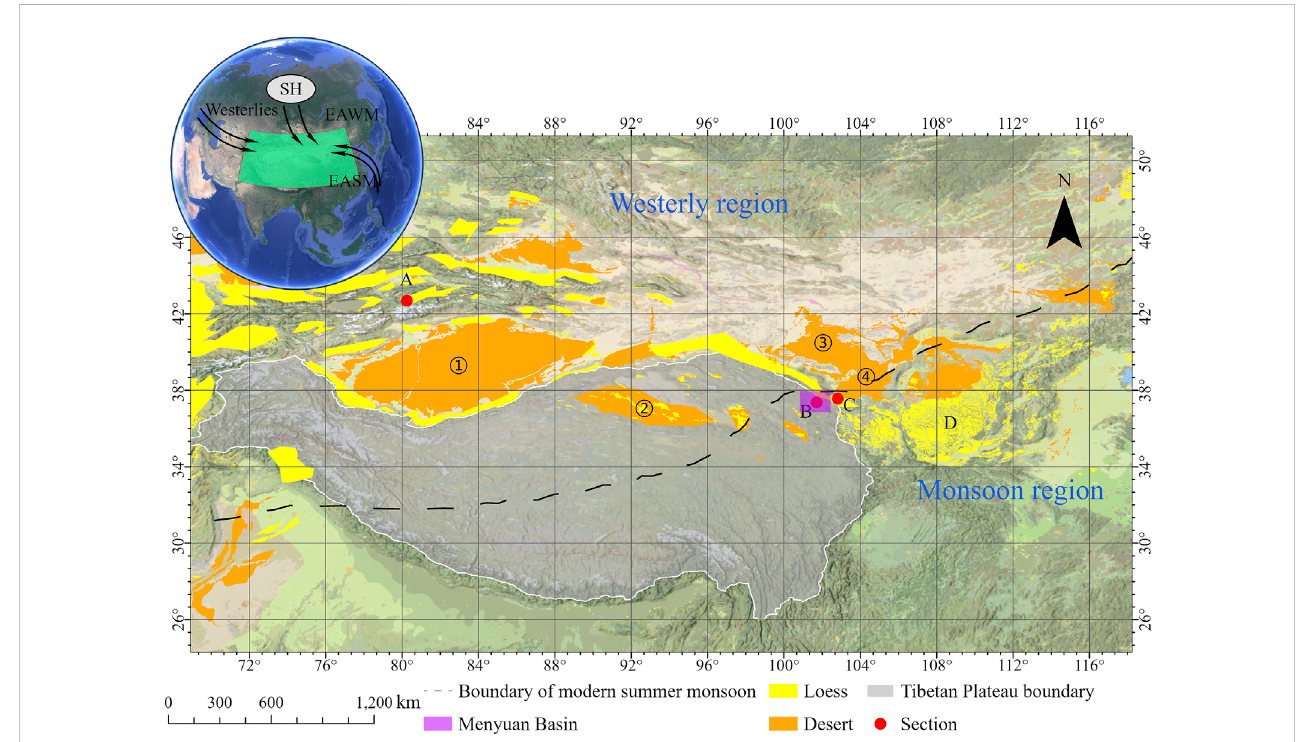
FIGURE 1 Schematic map of loess sediments and desert areas in the Tibetan Plateau. The grey area with a white line is the extent of the Tibetan Plateau (Ren and Pan,2019);theyellowandorangeareasrepresentthelocationsofloessdepositsanddeserts,respectively[modi fi edfrompriorpublications(WangandZhang, 1980;Wang,2013;Börkeretal.,2018)];theblackdashedlinerepresentstheedgeofthemodernsummermonsoon(Chenetal.,2019);thepurplesquareisthe main study area of this paper, the Menyuan Basin; ① , ② , ③ , and ④ represent Taklimakan Desert, Qaidam Desert, Badain Jaran Desert, and Tengger Desert, respectively; English letters A, B, C and D represent Zhaosu loess (Jia, 2014), Menyuan loess, Wuwei loess (Zhang H et al., 1997), and Chinese Loess Plateau loess, respectively. The image in the upper right corner was modi fi ed from a previous publication (Song et al., 2021). EAWM: East Asian winter Monsoon; EASM: East Asian summer Monsoon; SH: Siberian High; the base map is based on data from https://tiles.arcgis.com/tiles/P3ePLMYs2RVChkJx/